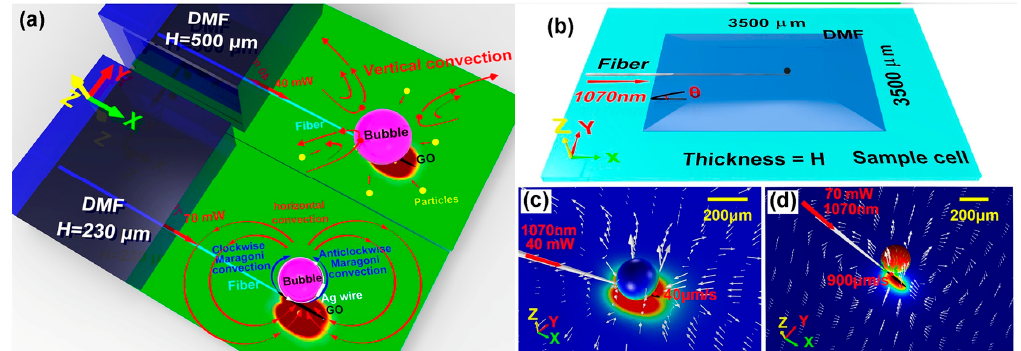
Figure 20. Simulation of thermal convection when the bubble is located at H = 230 μ m and 500 μ m and P = 40 mW and 70 mW [93]. ( a ) Schematic model of different functional flows. ( b ) Simulated model of the microfluidic system. ( c ) Vertical convection when a 160 μ m diameter microbubble is located above the heater with T = 400 K at H = 500 μ m and P = 40 mW. The longest arrow shows the maximum velocity of 40 μ m/s. ( d ) Horizontal convection induced by the heater when the 160 μ m diameter microbubble is located at the side of the graphene oxide (GO) heater with T = 450K at H = 230 μ m and P = 70 mW. The longest arrow shows that the maximum velocity of 900 μ m/s. Marangoni convection (green arrows) at the surface of the bubble would influence movement of particles when the thickness of the N, N-Dimethylformamide (DMF) was less than 300 μ m. Flow-induced deformation of the bubble is not considered in these simulations.